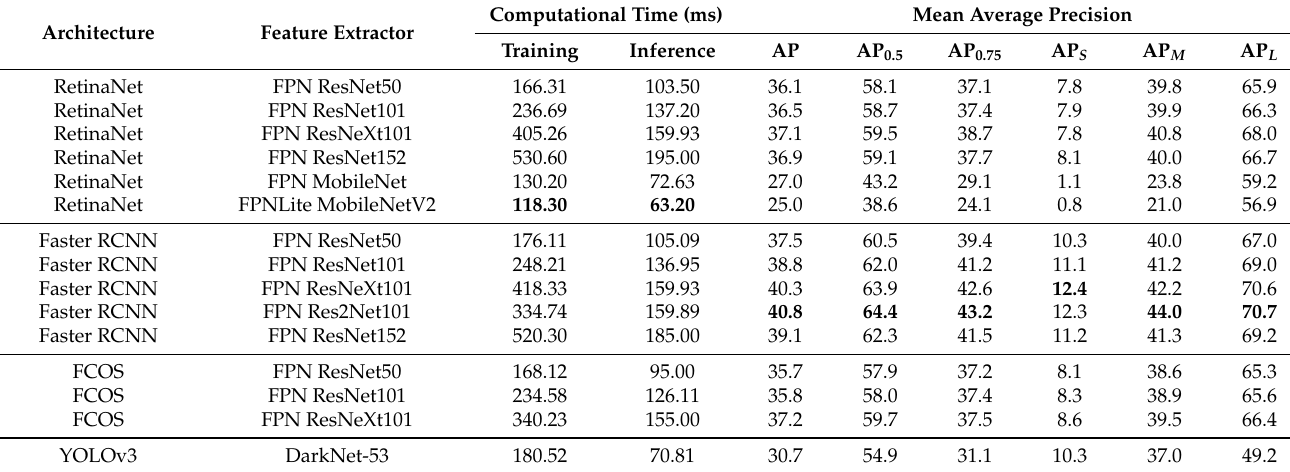
Table 4. COCO precision metrics and computation time of all models with high-resolution images. S, M, and L indicate small, medium and large objects respectively. The best results are highlighted in bold. Architecture